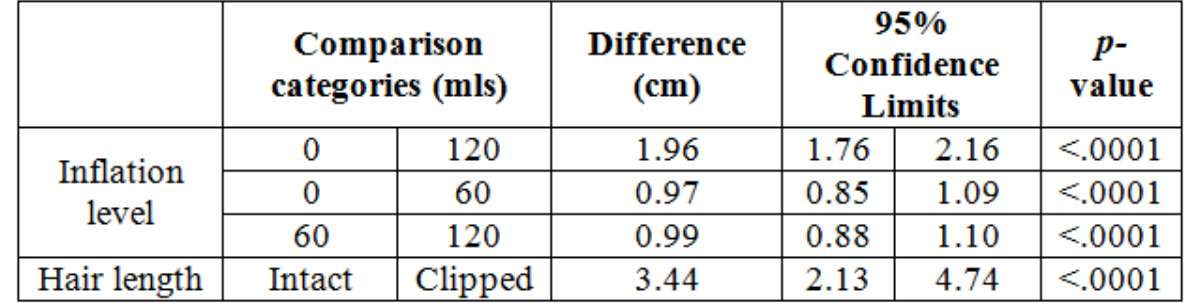
levels and different hair